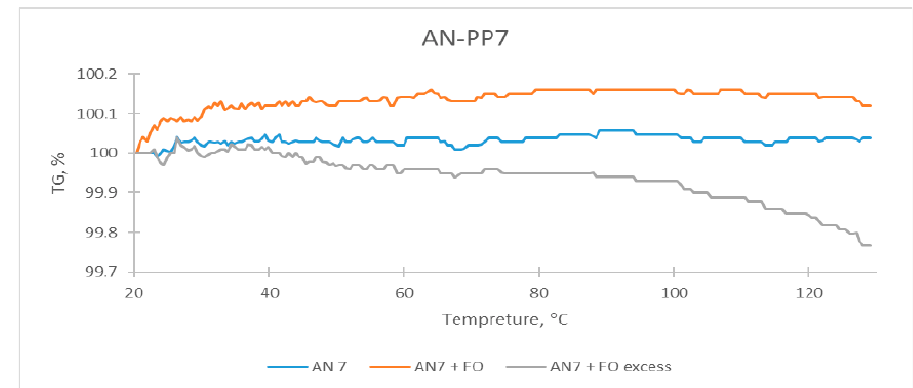
Figure 3. TG results of AN-PP7.